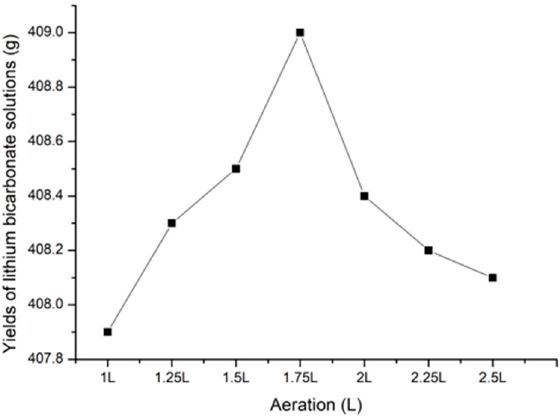
Figure 2. The yields of lithium bicarbonate solutions with different CO 2 aeration.